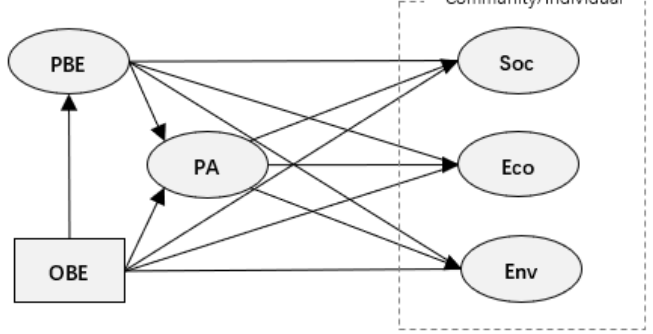
Figure 2. The structure of individual- and community-level models (Source: authors).